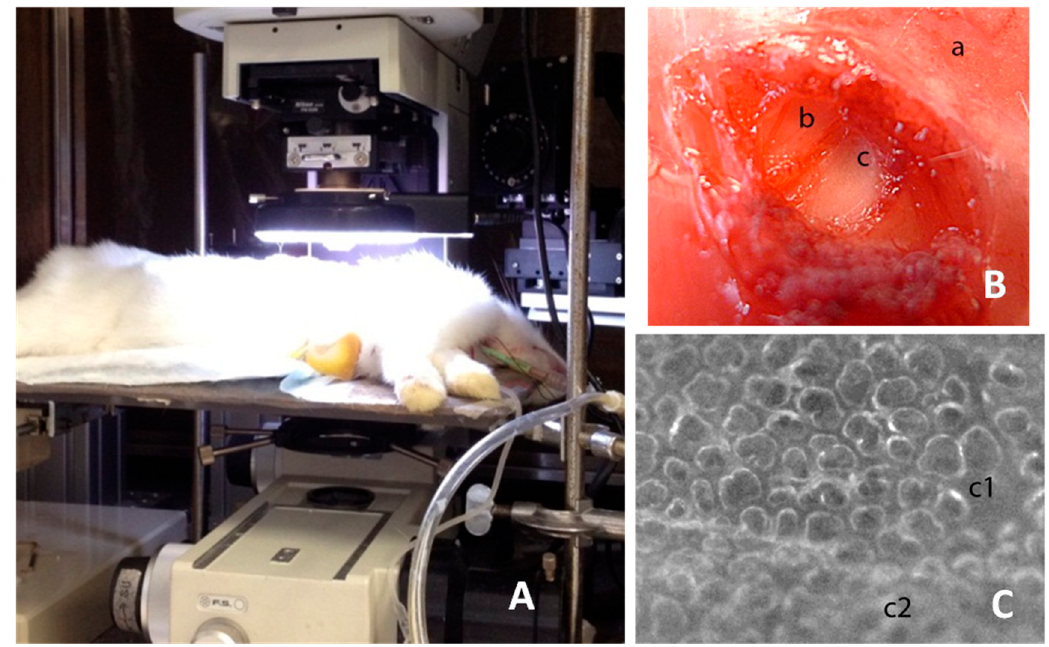
Figure 1. The image shows the experimental setup and the phases to create the pleural window. ( A ) the placement of the animal under the microscope; ( B ) shows the external intercostal layer (a), the internal intercostal layer (b), and the denuded parietal pleura (c); ( C ) shows the portion of the stripped parietal pleura (c1) so as to create the “pleural window”, allowing a neat view of the underlying lung surface (note the difference with the unstripped portion c2). The figure is free of ethical problems and the experimental setup shown is unprotected for publication.